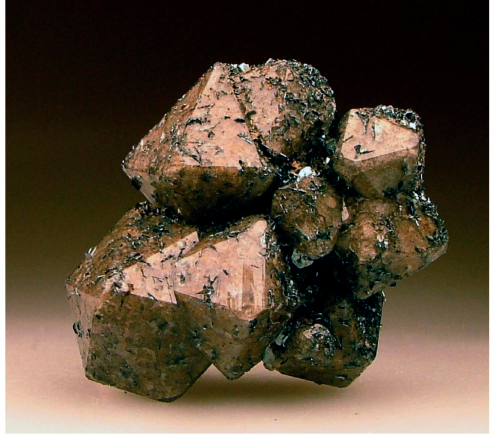
Figure 18. Quartz and hematite, Chub Lake prospect. 7.1 cm. Chamberlain Collection, NYSM C4371.